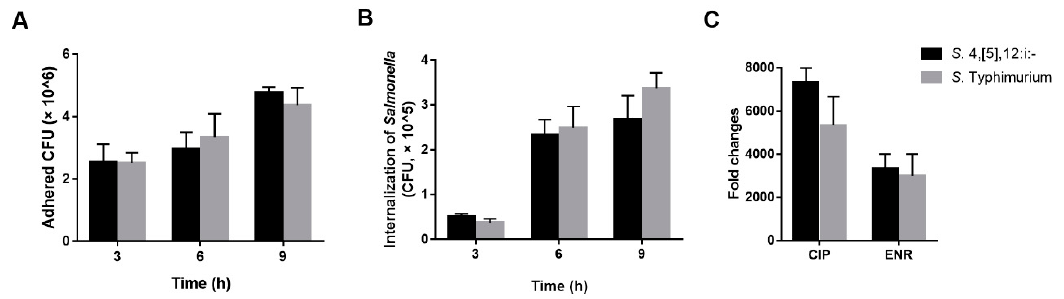
Figure 4. Adhesion to and internalization into IPEC-J2 of S. Typhimurium and S. 4,[5],12:i:-. Salmonella populations adhered to ( A ) and internalized into ( B ) IPEC-J2 were determined after 3, 6 and 9 h of interaction, respectively. The fold change of intracellular MIC to extracellular MIC for S. Typhimurium and S. 4,[5],12:i:- ( C ). Each experiment was done in triplicate, and differences between groups were compared using Student’s t test.